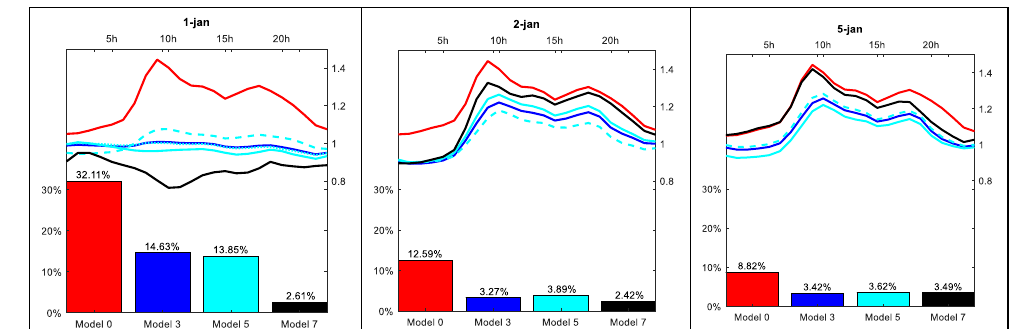
Figure A1. Regular days.